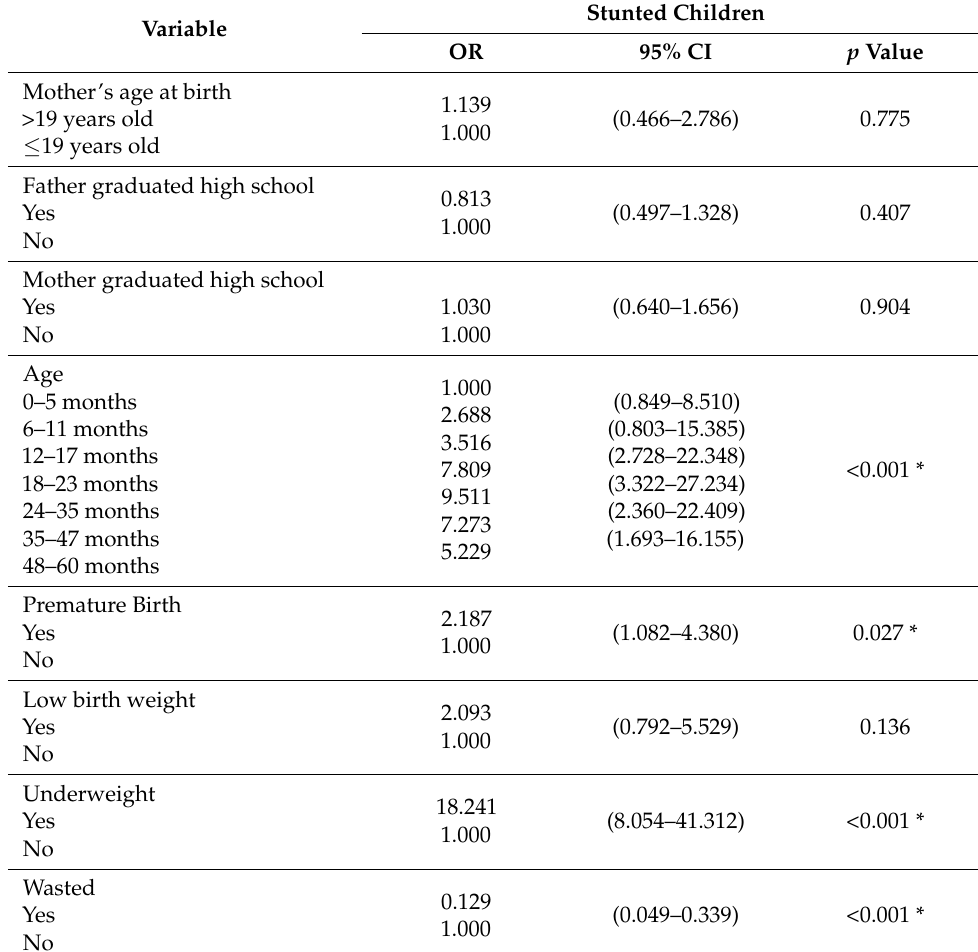
Table 2. Factors Associated with Stunting in South